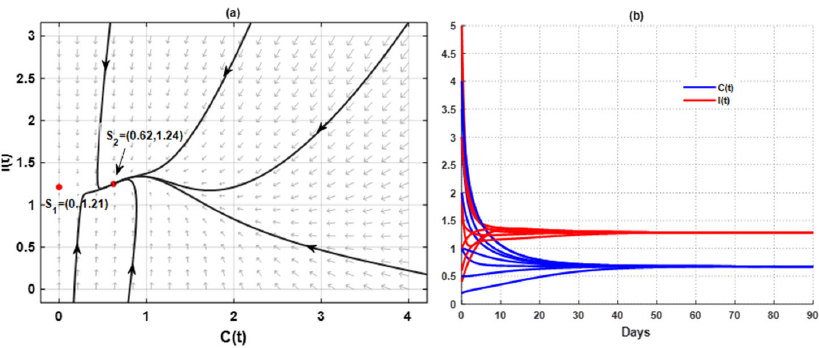
Figure 4. Numerical simulations of the CICV model for the data given in Table 1 with 𝛾 (cid:3404) 0 . ( a ) Phase portrait of the CICV model. ( b ) Time series of the CICV model. Phase portrait of the CICV model. ( b ) Time series of the CICV model. portrait of the CICV model. ( b ) Time series of the CICV